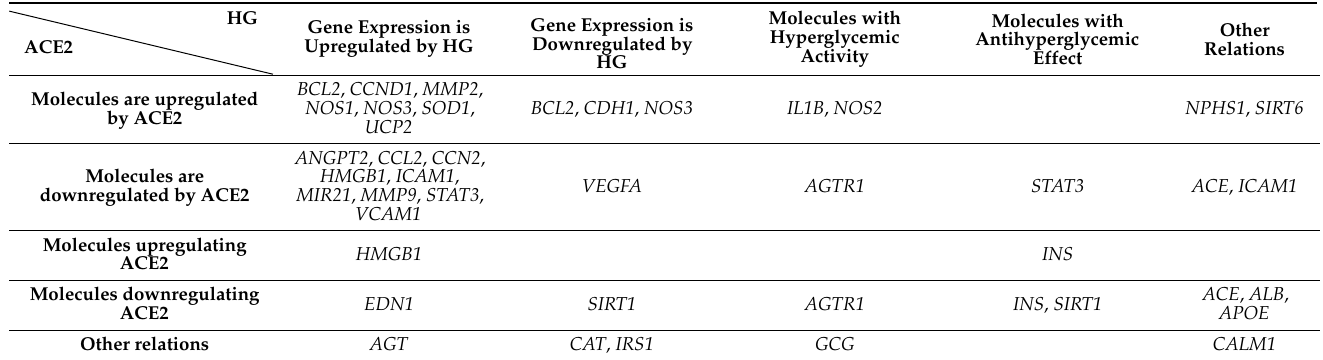
Table 2. Types of associations of the genes/proteins from hyperglycemia-related and ACE2-related networks with high glucose (HG) and